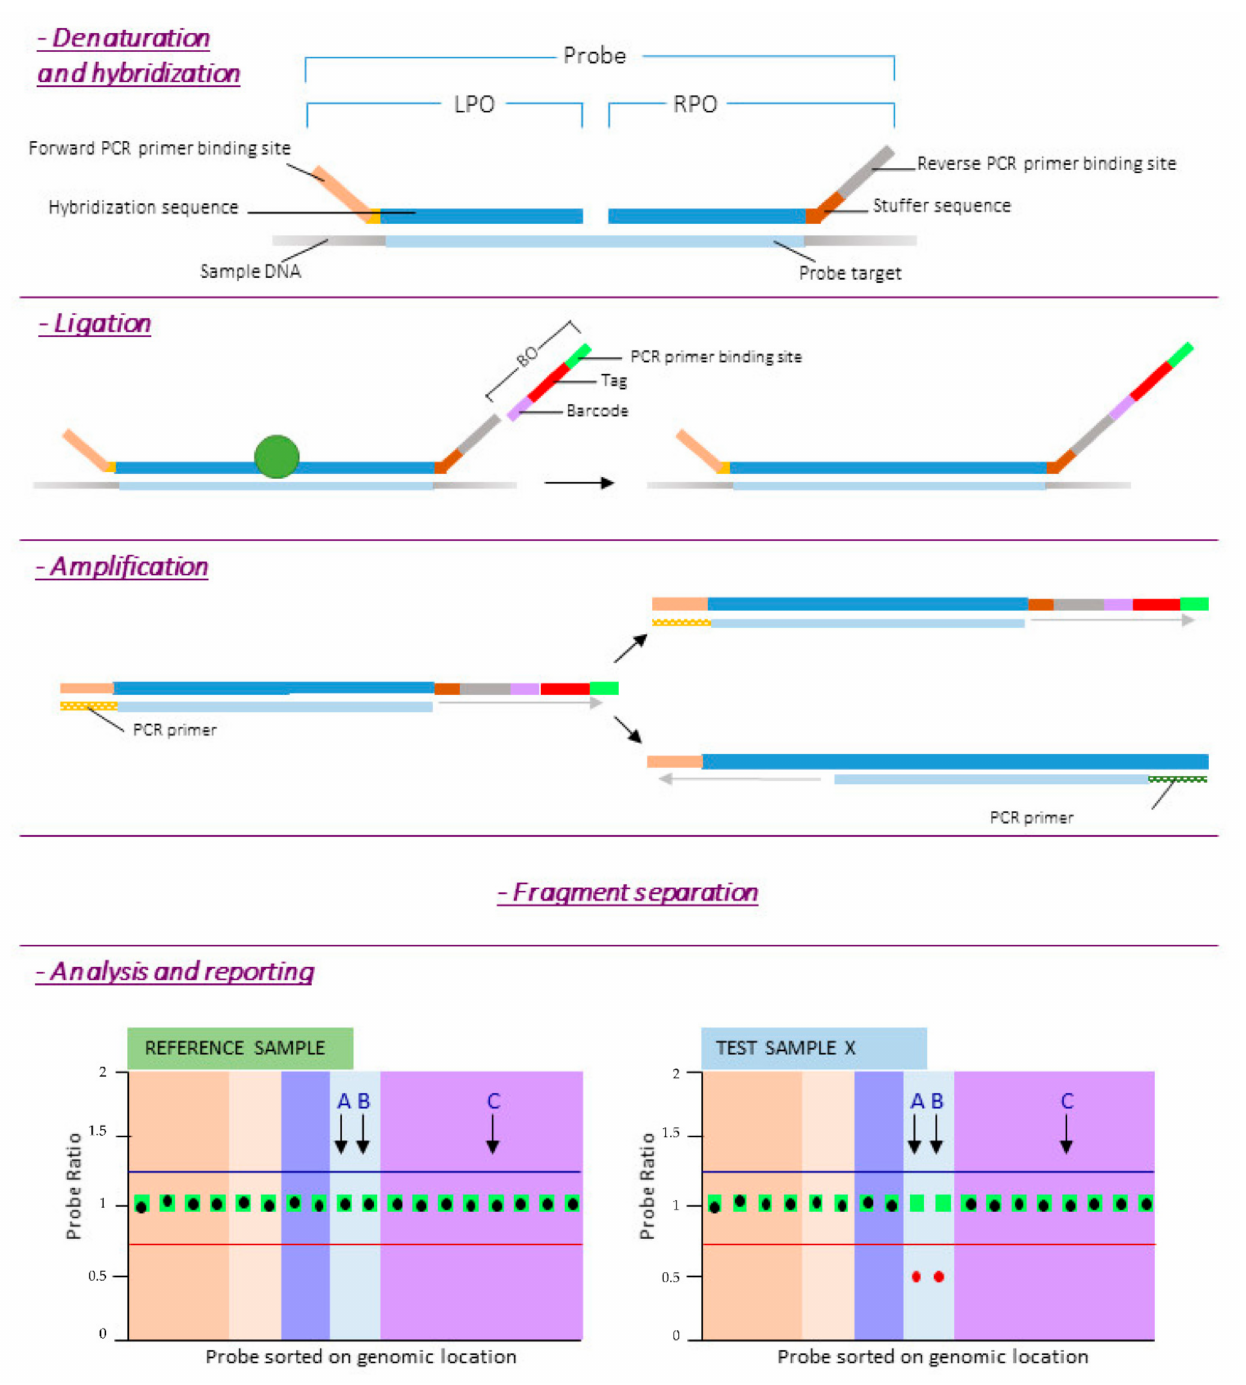
Figure 2. MLPA procedure. Reference DNA samples are required to determine the relative copy number of each of the probes. After denaturation of the target DNA, the left and right probe oligos (LPO and RPO respectively) are hybridized to their target sequence overnight (at least 16 h). The next day, the two oligonucleotides are enzymatically ligated and a barcode oligo (BO) is incorporated into the amplicon for sample identification. After PCR, products are separated by length. Finally quality check is performed and probe ratios calculated. A probe ratio of 1.0 corresponds to a normal diploid copy number, a probe ratio of 0.5 to a heterozygous